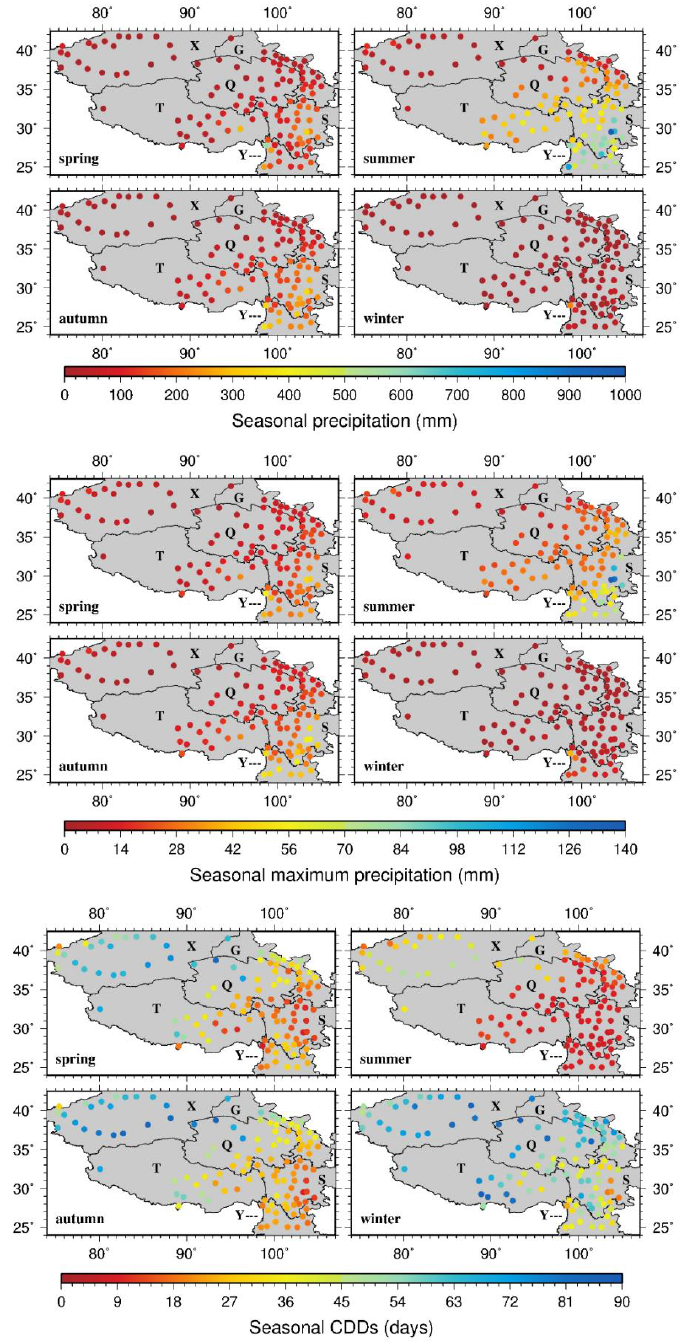
Figure 2. Spatial distributions of seasonal precipitation variables.